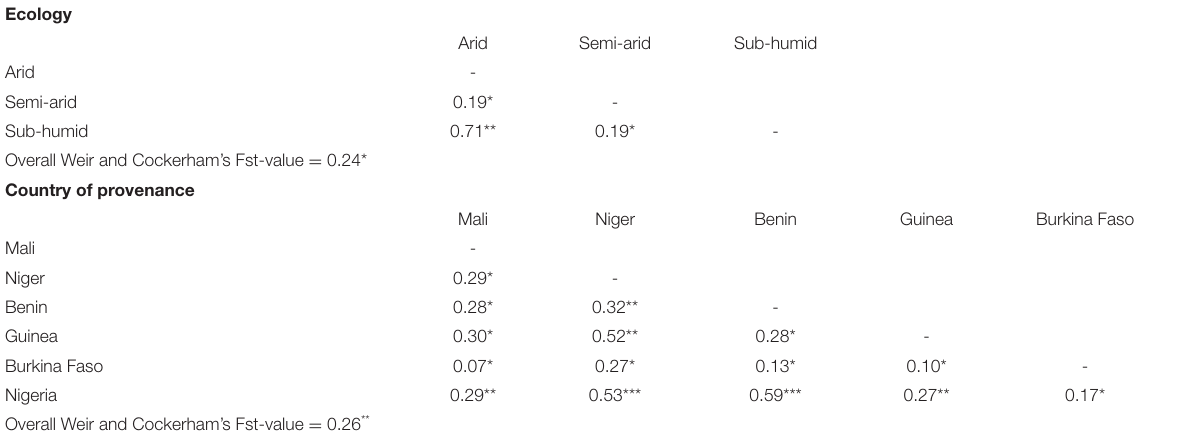
Arid Semi-arid Sub-humid